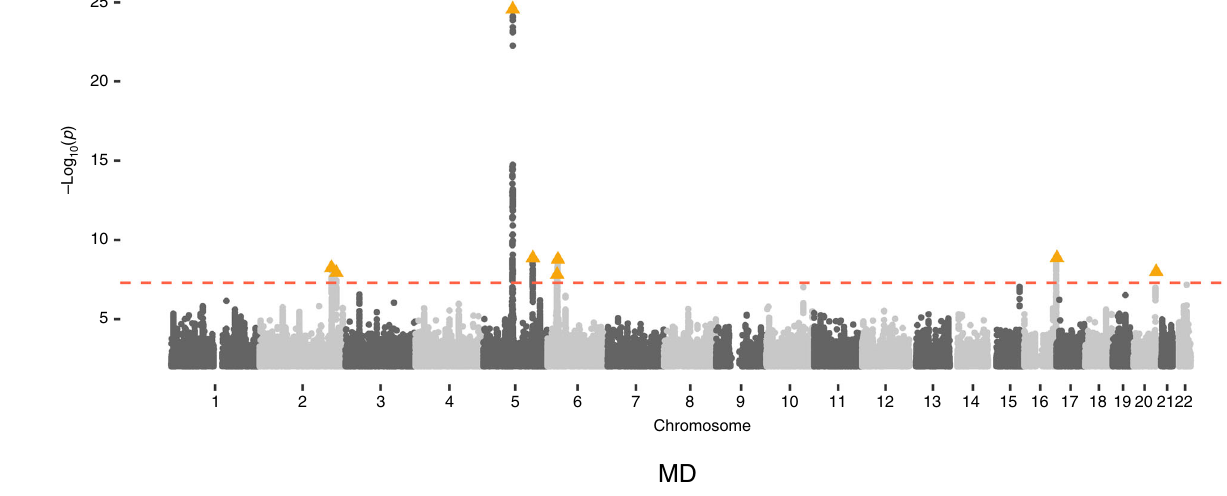
Fig. 1 Genome-wide association Manhattan plots for WMH, FA and MD. Manhattan plots are shown for each of the phenotypes: WMH (top), FA (middle), and MD